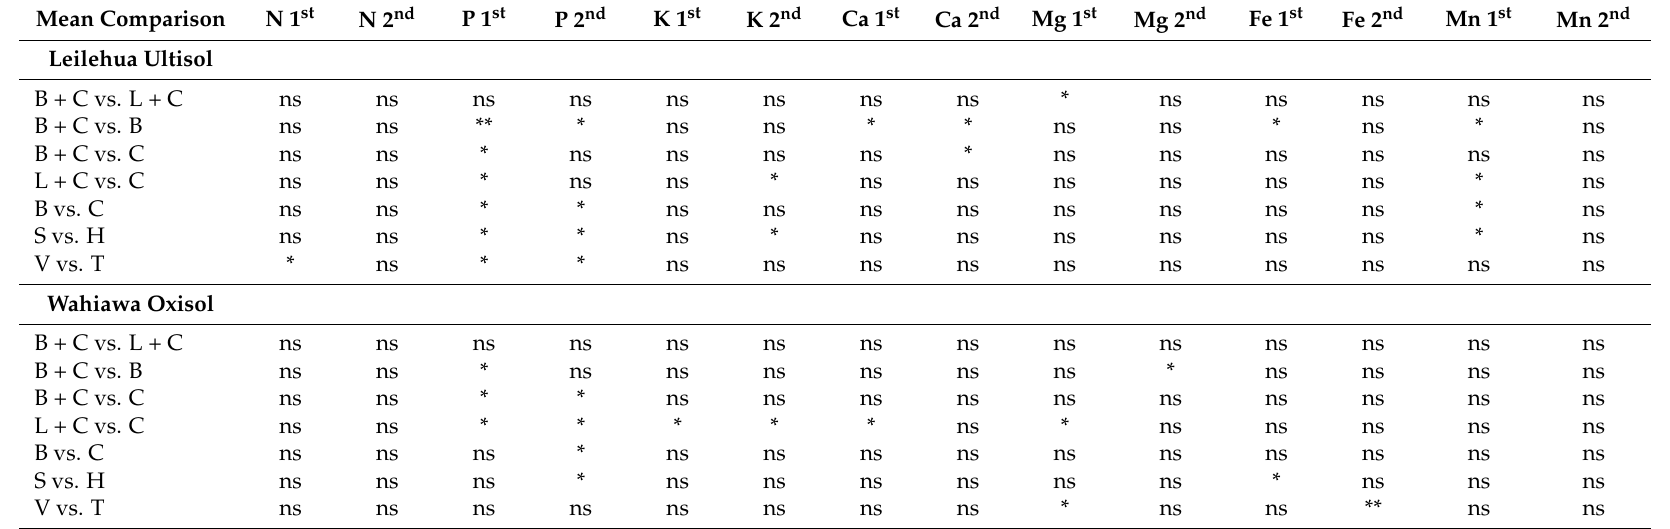
Table 5. The results of the ANOVA and pair-wise t probabilities on plant nutrients in the first and second plantings as affected by biochar or lime and compost